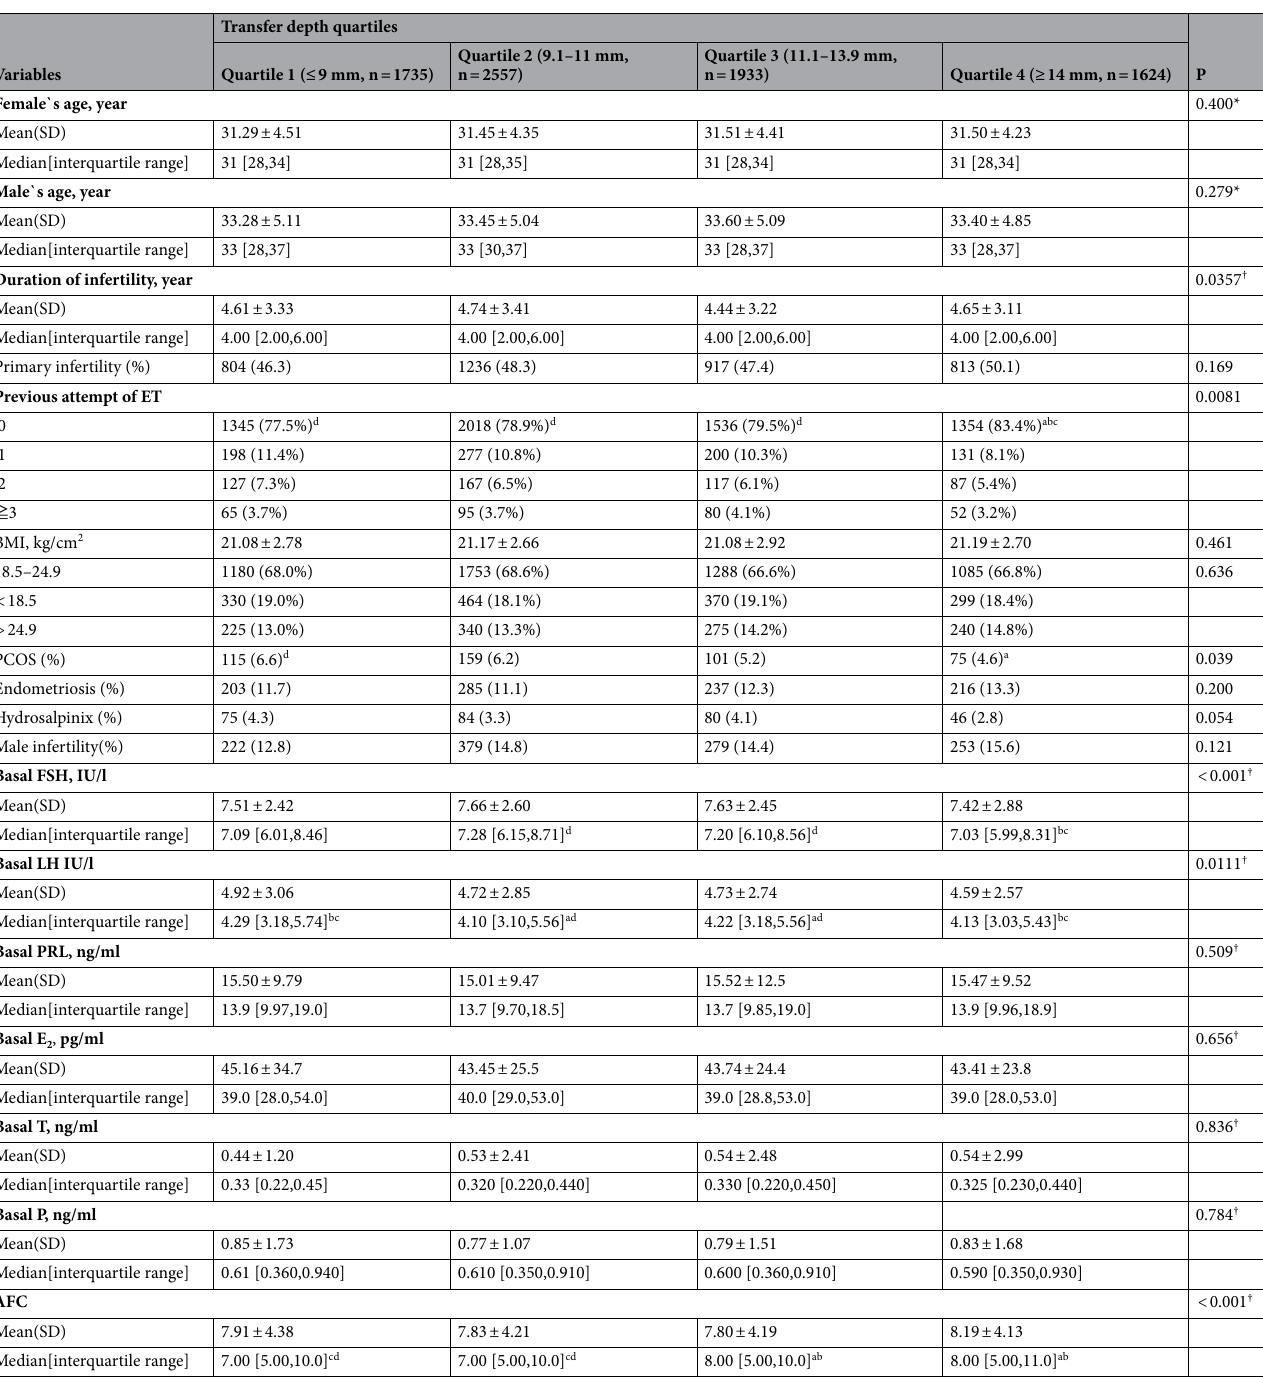
Table 1. Baseline characteristics and ovarian stimulation parameters. Data were presented as mean ± SD and median [interquartile range] for continuous variables, and n (percentage) for categorical variables. † Indicates the data were non-normally distributed and analyzed using Kruskal Wallis test. *Indicates the data were normally distributed and analyzed using one way ANOVA. a Indicates that the group differs from quartile 1 at p value of 0.0125; b Indicates that the group differs from quartile 2 at pvalue of 0.0125; c Indicates that the group differs from quartile 3 at p value of 0.0125; d Indicates that the group differs from quartile 4 at p value of 0.0125. ET, embryo transfer; BMI, body mass index; PCOS, polycystic ovarian syndrome; FSH, follicle-stimulating hormone; LH, luteinizing hormone.; PRL, prolactin; E 2 , estradiol; T, testosterone; P, progesterone; AFC, antral follicle